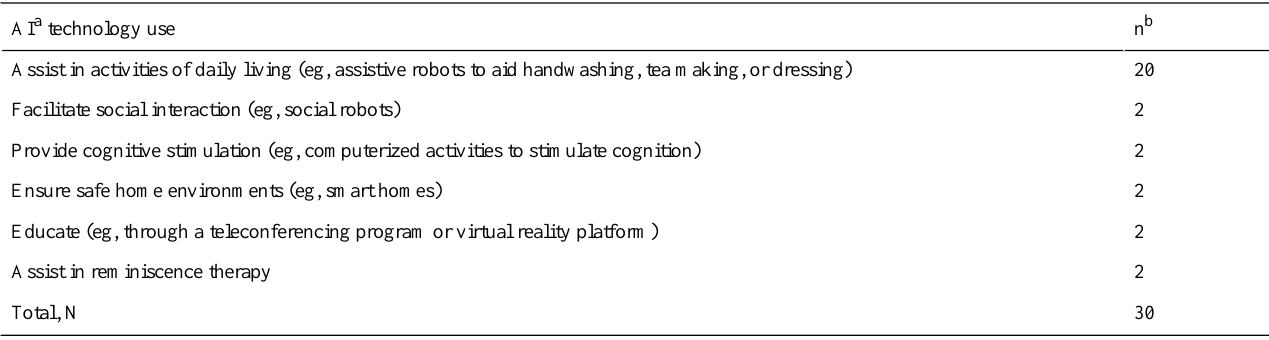
Table 2. Summary of artificial intelligence technology’s intended